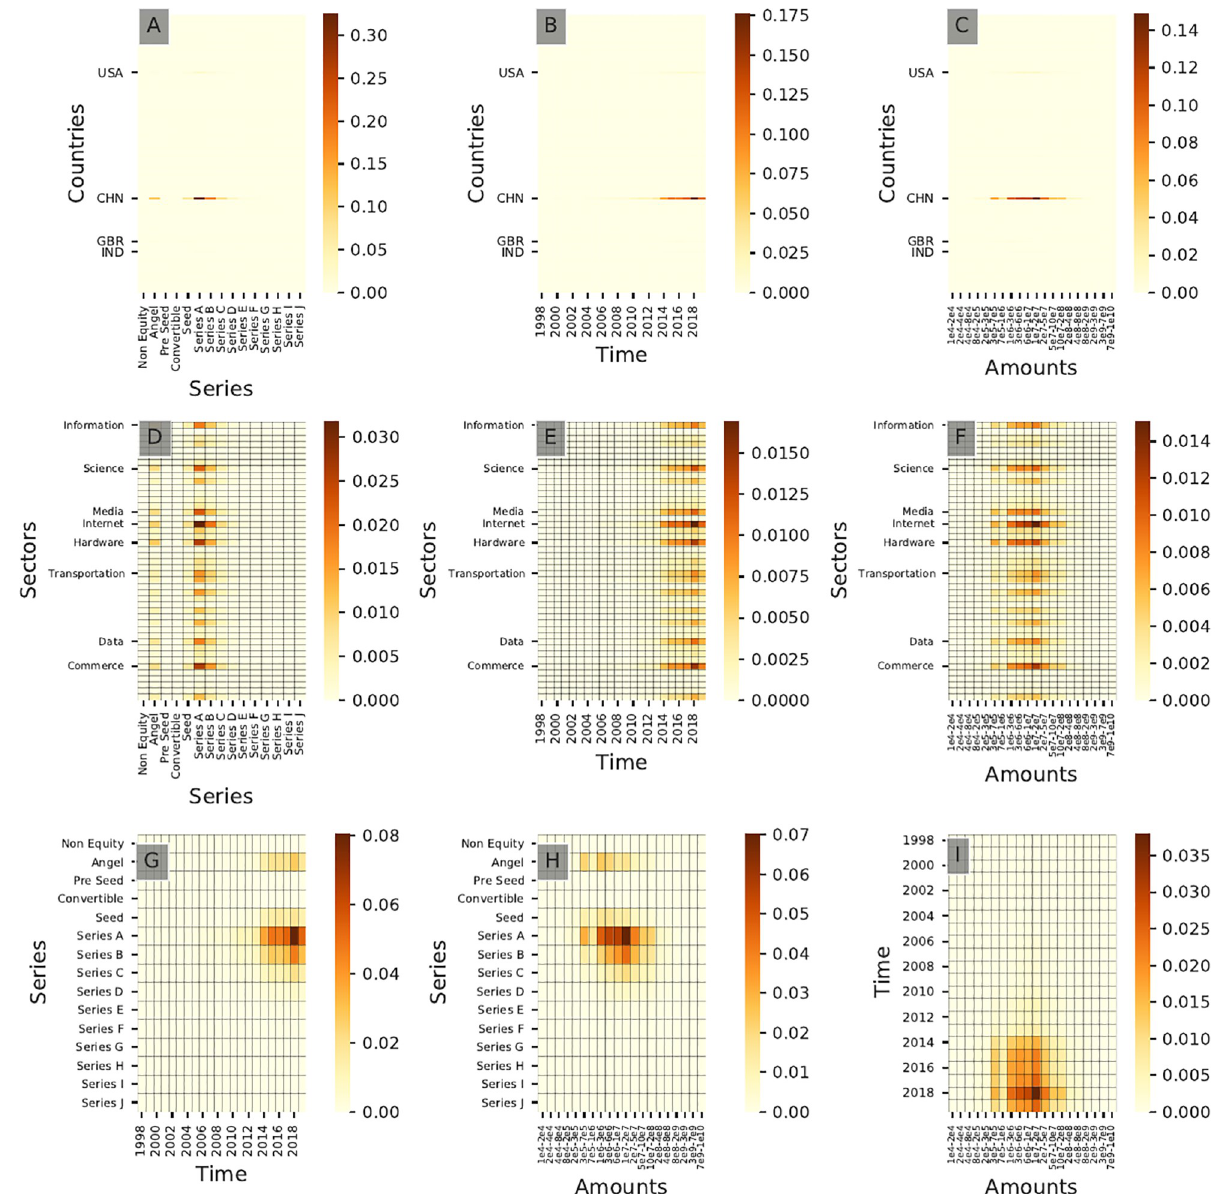
Fig 11. Cross-interaction heatmaps for community B6. This community corresponds to China-focused investors. Only the top 8 sectors and the top 4 countries in terms of frequency of investments are labeled for readability purposes.